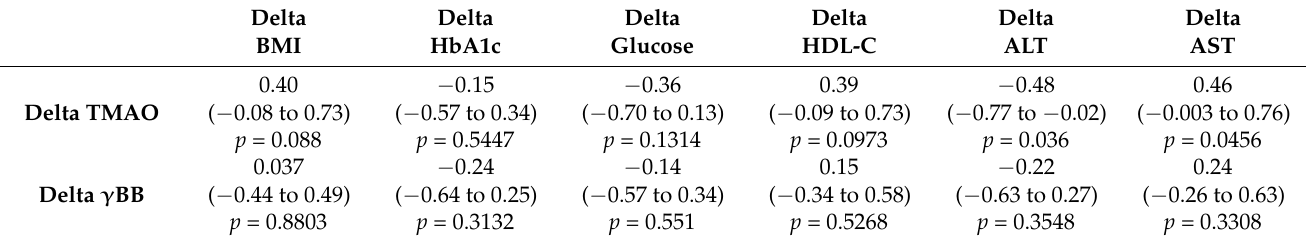
at baseline. Data are presented as Rho Spearman (95% confidence intervals) and have a p value.